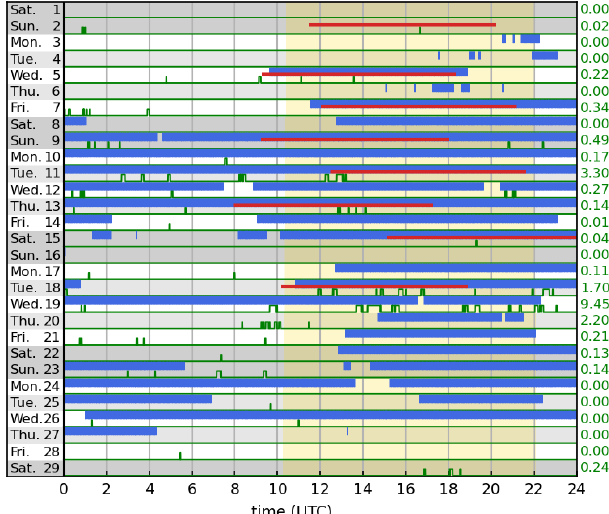
Figure 7. Availability of Poldirad data during February 2020 (blue bars) with rain events at BCO (green ticks) and HALO flight times (red lines). Green numbers to the right give daily precipitation sums (in mm) at BCO. Yellow shaded area indicates daylight time at Bar-